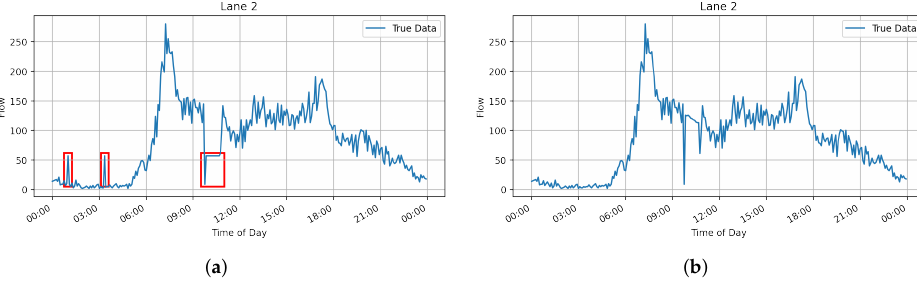
Figure 1. Differences between the substitution of zeros applying a general average and a moving average. ( a ) General Average; ( b ) Moving Average.